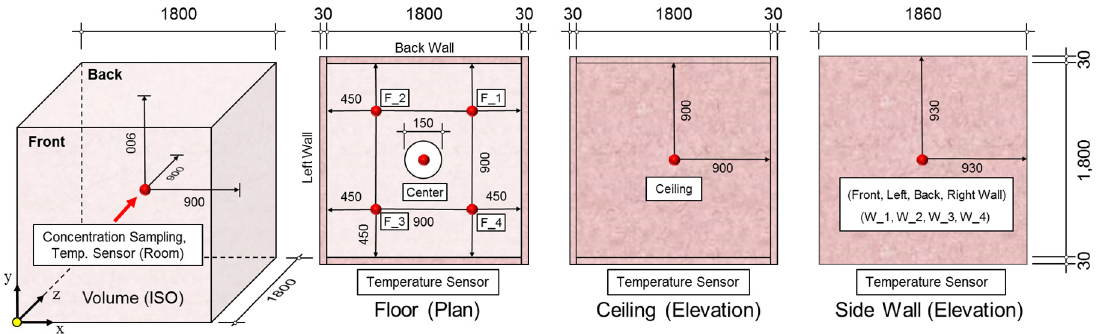
Figure 2. Sensor locations within the chamber.